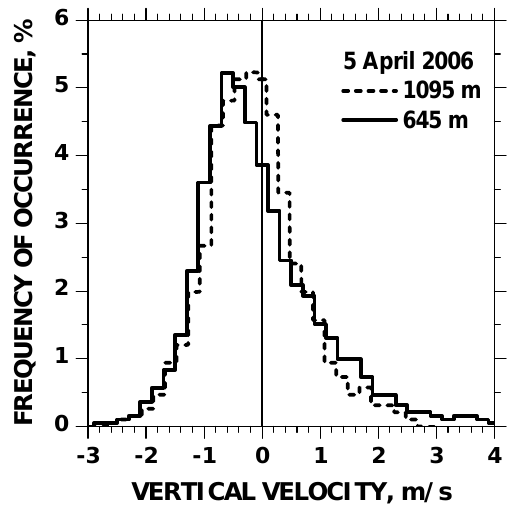
Fig. 4. Frequency of occurrence of vertical velocity measured with Doppler lidar on 5 April from 09:49–16:45LT. Distributions are presented for 645m height a.s.l. (lower ABL) and 1095m height a.s.l. (upper ABL before 14:00LT).